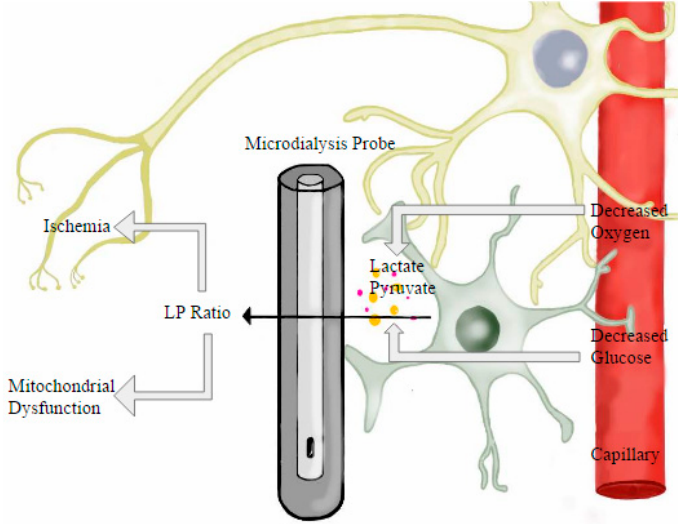
Figure 3. Figure demonstrating the result of decreased brain oxygen and consequent lactate production. A microdialysis probe detects biomarkers, such as Lactate/Pyruvate ratio (LP) that will indicate ischemia or mitochondrial dysfunction.